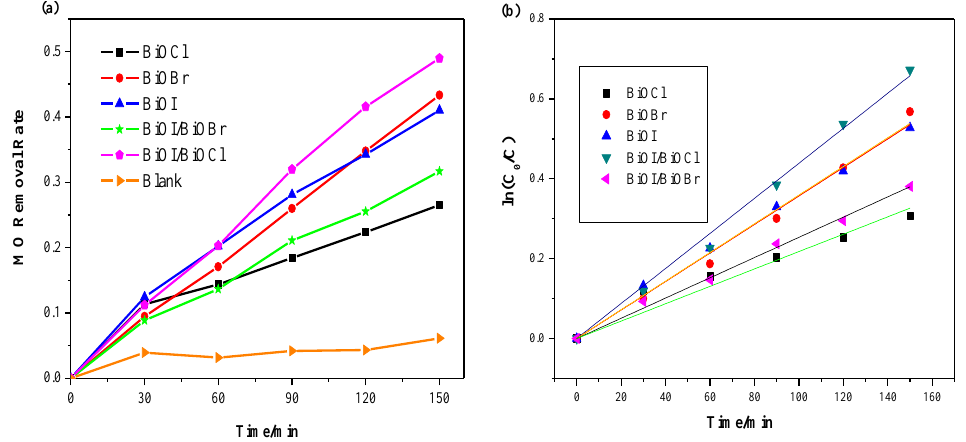
Figure 9. ( a ) Comparison of photodegradation efficiencies of different samples under UV irradiation; ( b ) pseudo-first-order kinetics curves of MO degradation over different samples under UV irradiation. Based on the curves from Figures 8b and 9b, the calculated values of k app and R 2 are displayed in Relative to BiOX (X = Cl, Br), BiOI has a narrow band gap of around 1.9 eV, which can